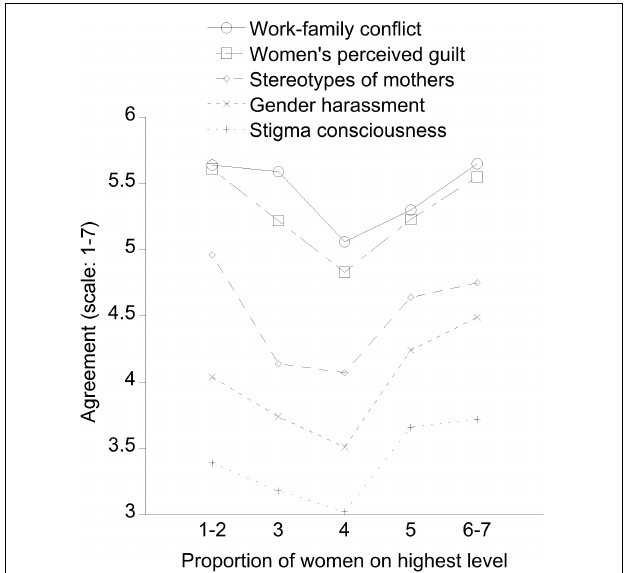
FIGURE 2 | Degree to which women in leadership positions (both on the highest and intermediate level), depending on the proportion of female leaders on the highest level in their organization (scale: 1–2 – almost only men, to 6–7 – almost only women), feel work–family conflict, perceive that other women feel guilty because of their work–family obligations, report that negative stereotypes of mothers and gender harassment exist in their organization, and report to be stigma conscious. All variables show quadratic trends, with lowest agreement (1 = “do not agree at all” to 7 = “completely agree”) going along with similar proportions of men and women leaders (i.e., gender